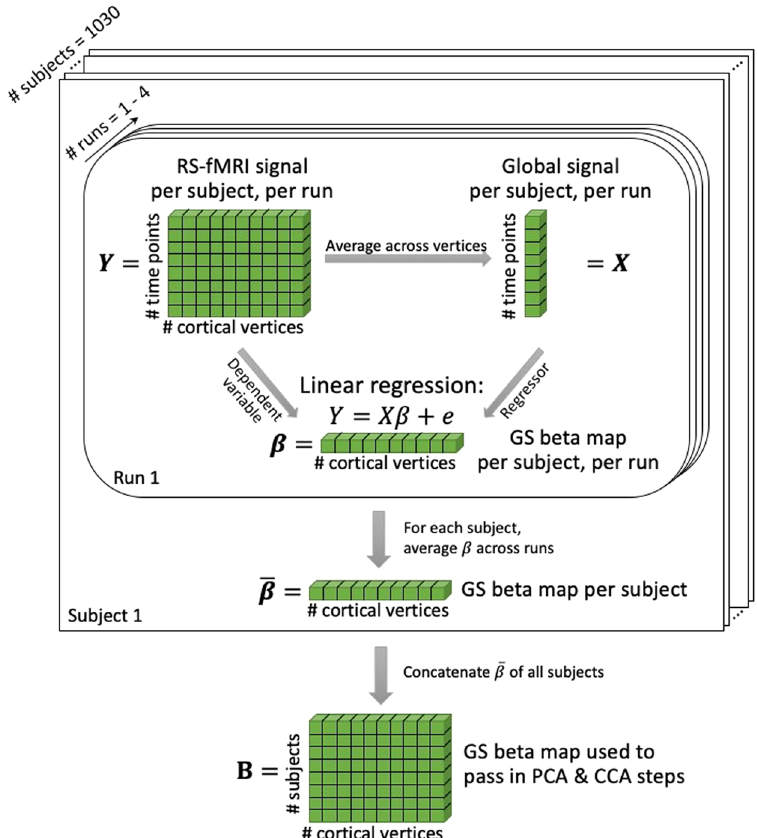
Figure 1. Illustration of global signal beta map calculation. For each subject and each run, the global signal ( X ) was computed as the averaged timeseries across all cortical vertices. The global signal was then regressed from the timeseries of each vertex ( Y ), resulting in the GS beta map of a given run (β). Averaging across all runs within a given subject, we obtained the GS beta map of that subject. The GS beta maps for each subject were then used in subsequent PCA and CCA analyses ( B